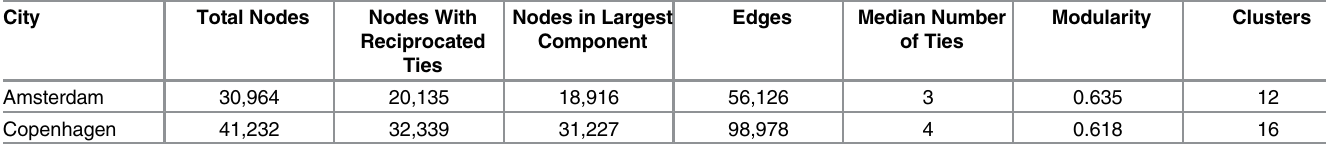
Table 1. Networks of Mutual Ties in Amsterdam and Copenhagen.